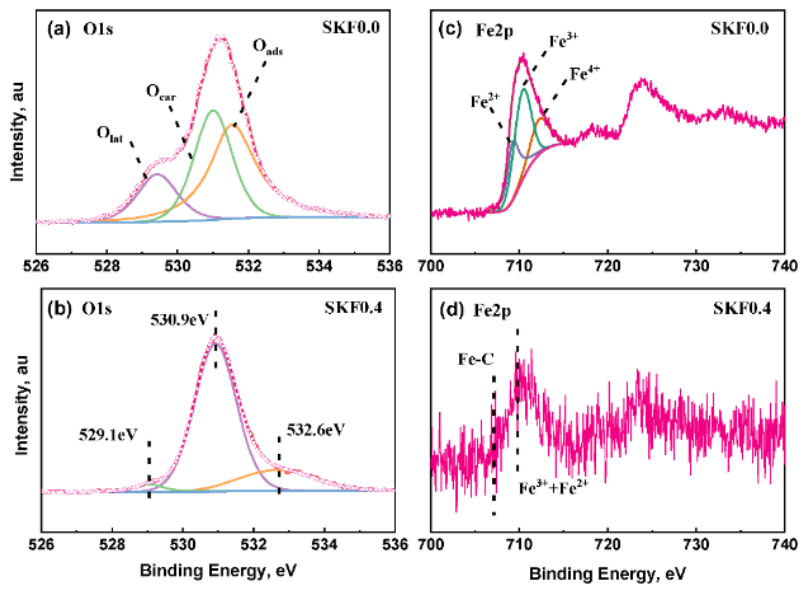
Figure 10. O 1s and Fe 2p XPS spectra and deconvolution of spend samples: ( a , c ) SKF0.0; ( b , d ) SKF0.4 (H 2 /CO 2 = 3/1, 350 ◦ C, 1.0 MPa, GHSV = 7200 mL · gcat · − 1 · h − 1 ).